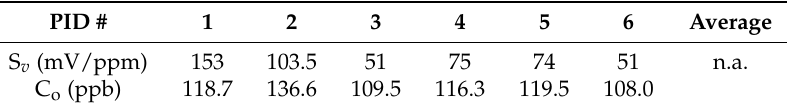
Table 1. Calculated C o for each photoionization detectors (PID).